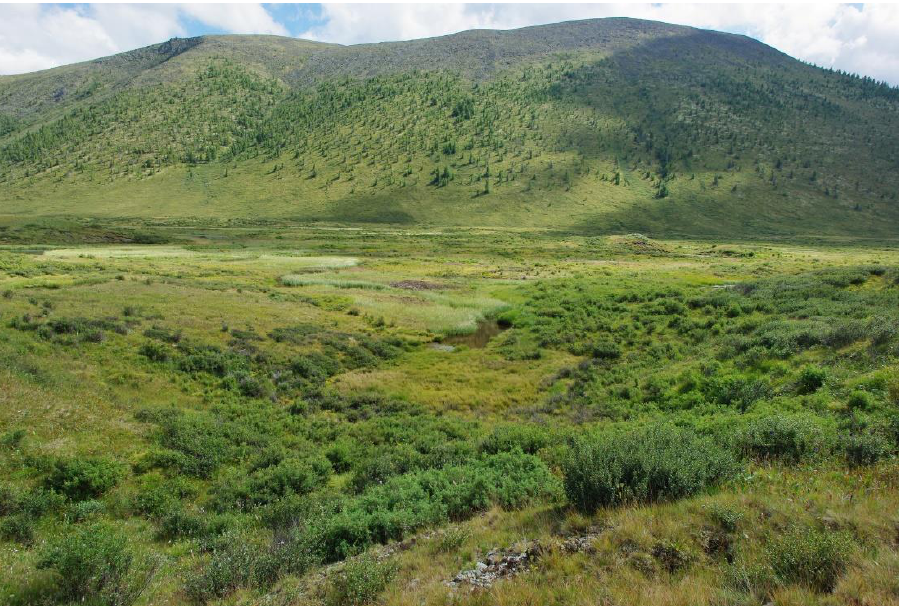
Figure 10. Flow (water) channel at the Adyr-Khem key site (photo by Volkov, 2021). On the slope, a forest belt is formed, which has two thermal boundaries—the “classical” upper forest line and the lower boundary associated with the sinking of cold air to the bottom of the Adyr-Khem valley.